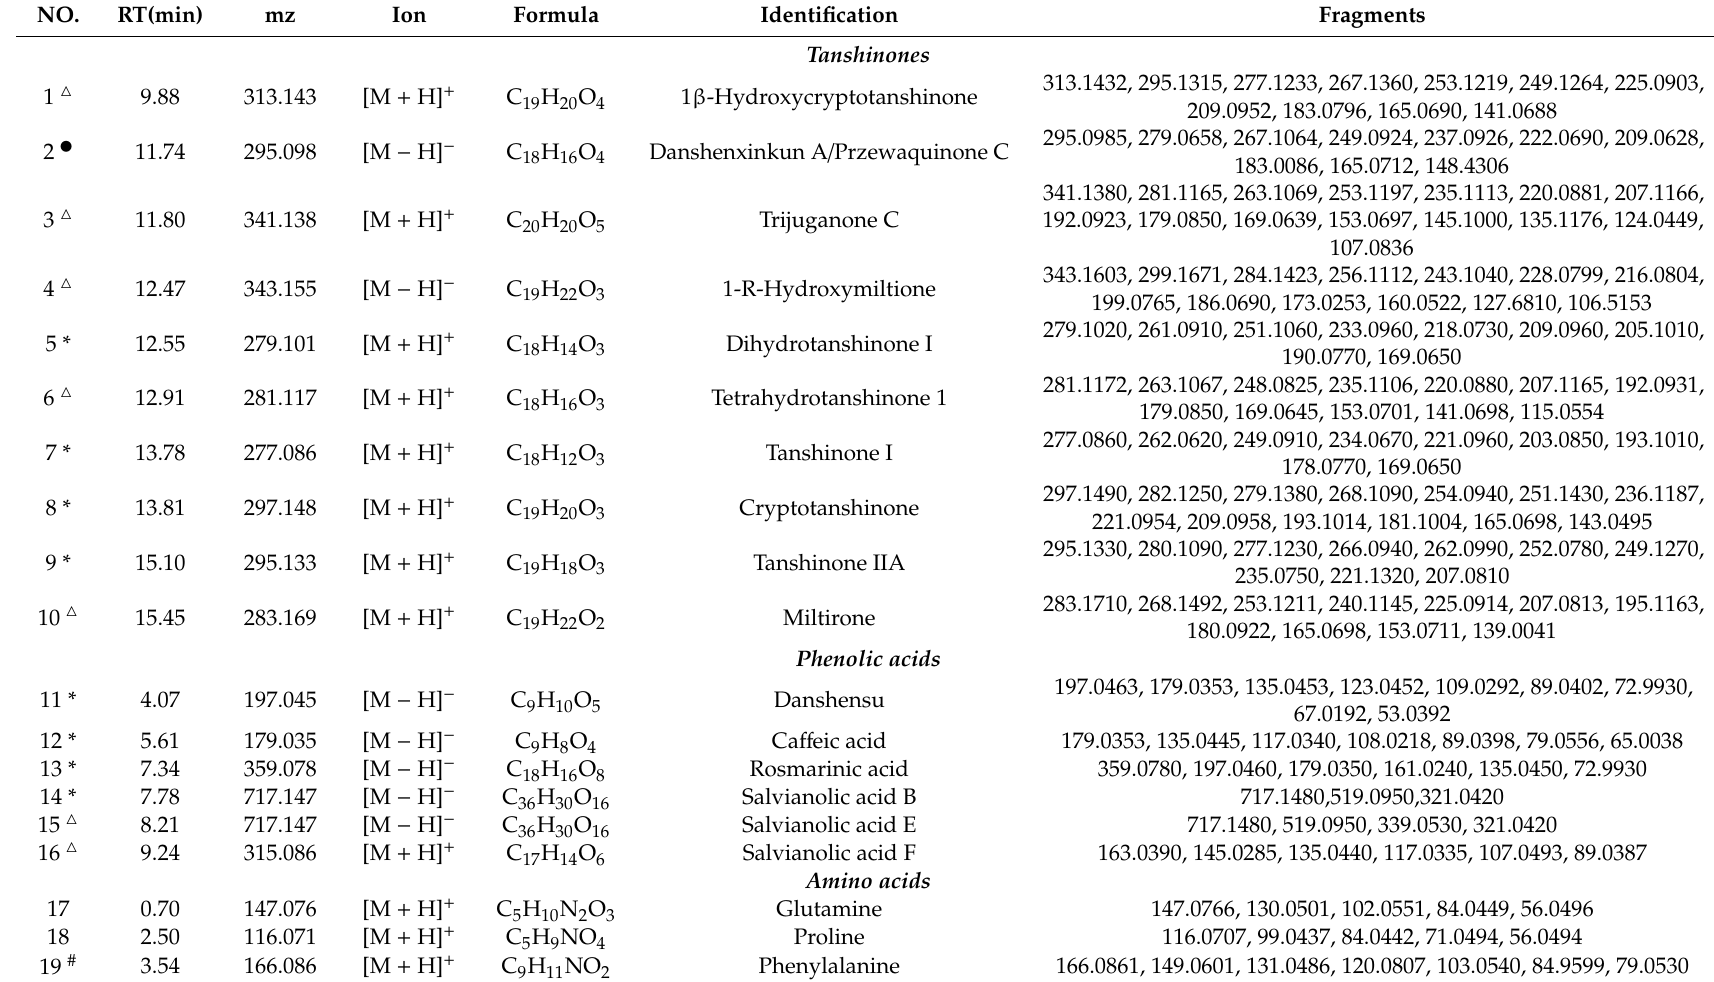
Table 2. The list of identified di ff erential metabolites and their characteristic fragment